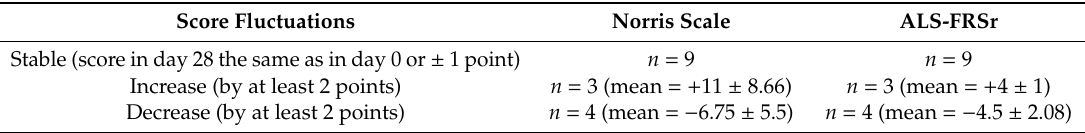
Table 1. Results of clinical assessment using amyotrophic lateral sclerosis (ALS) Functional Rating Scale (FRSr) and Norris scale 28 days after administration of lineage-negative cells.